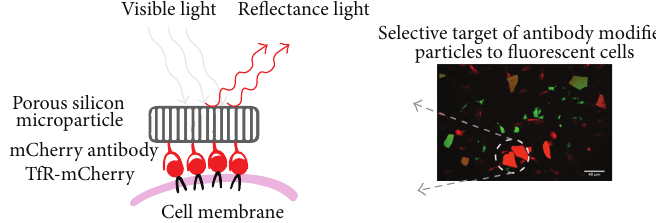
Figure 2: Covalent bonding of antibodies to P-Si microparticles for detection of cells (adapted from [23]).